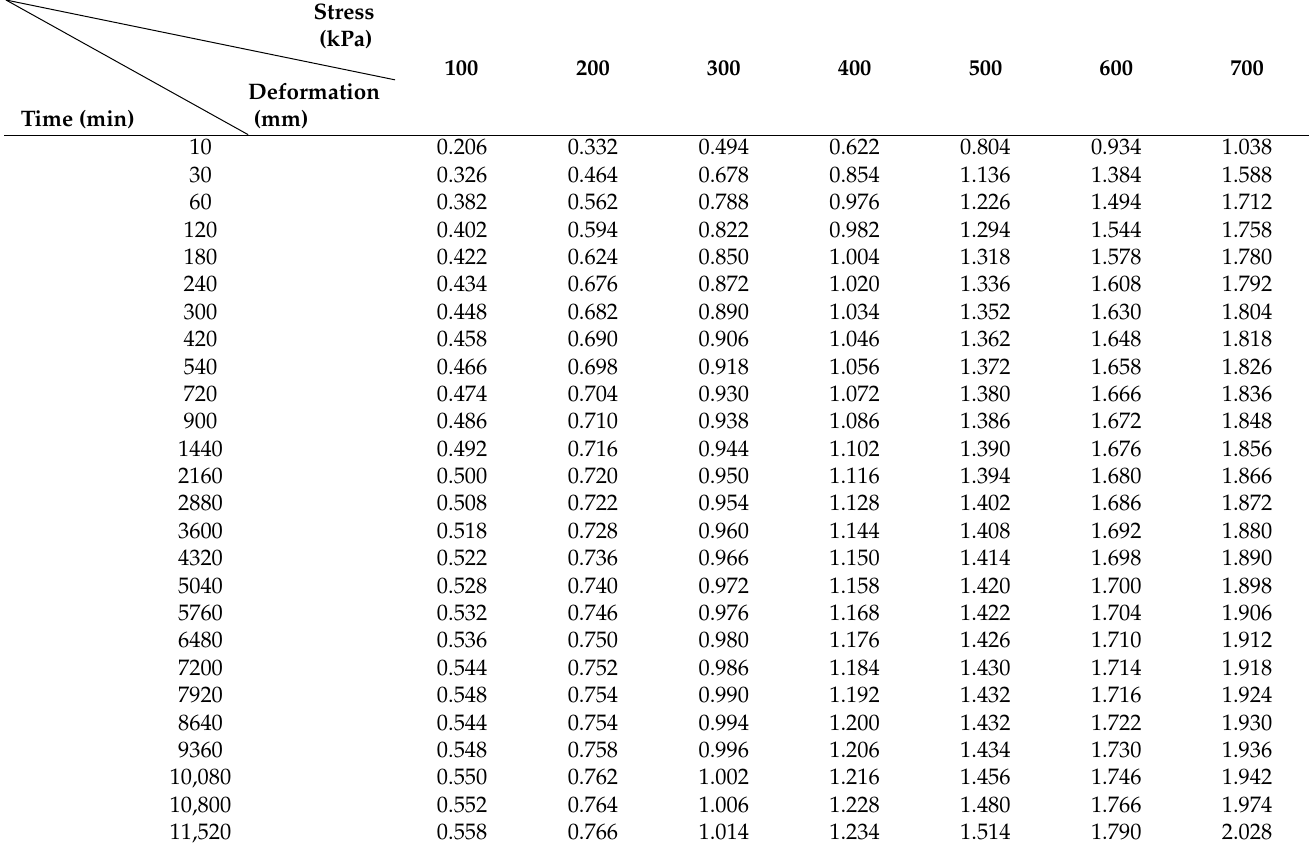
Table 5. Test results of silty